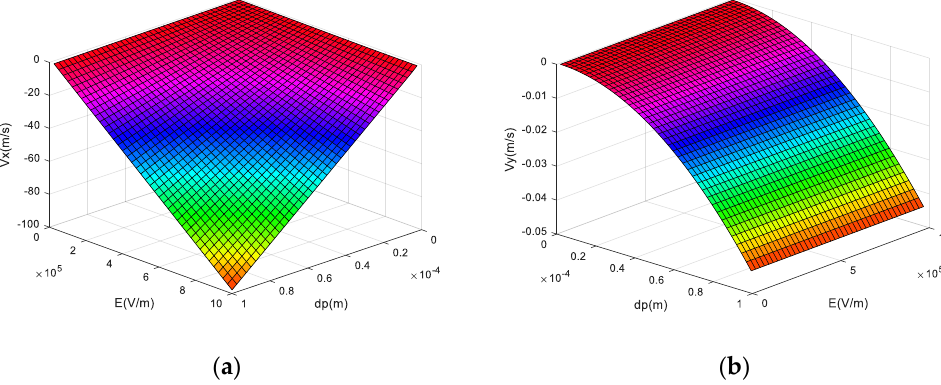
Figure 5. Dynamic velocity response of different electric field strengths and different particle diameters: ( a ) X -axis velocity response; and ( b ) Y -axis velocity response.